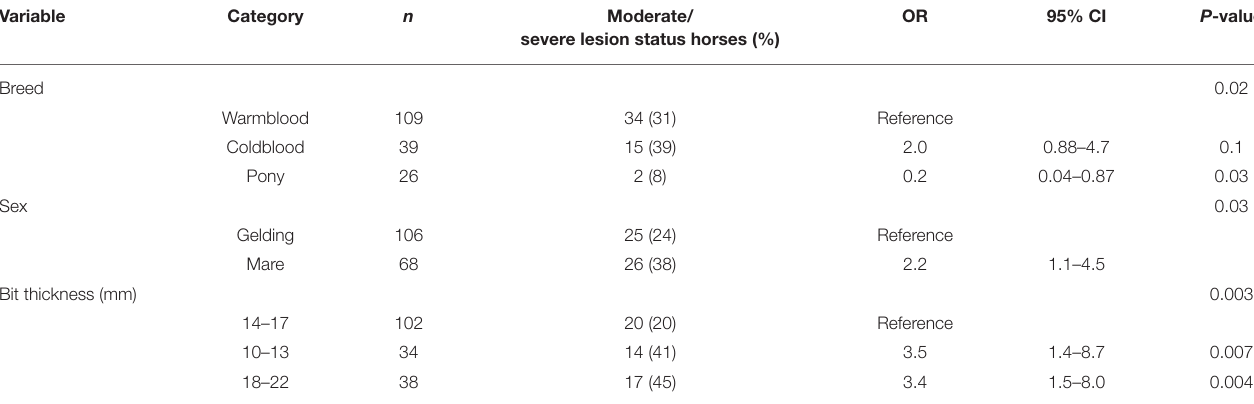
TABLE 2 | Event horses ( N = 174) and their risk factors for moderate or severe (CD) oral lesion status vs. no lesion or mild lesion (AB) status in the bit area.